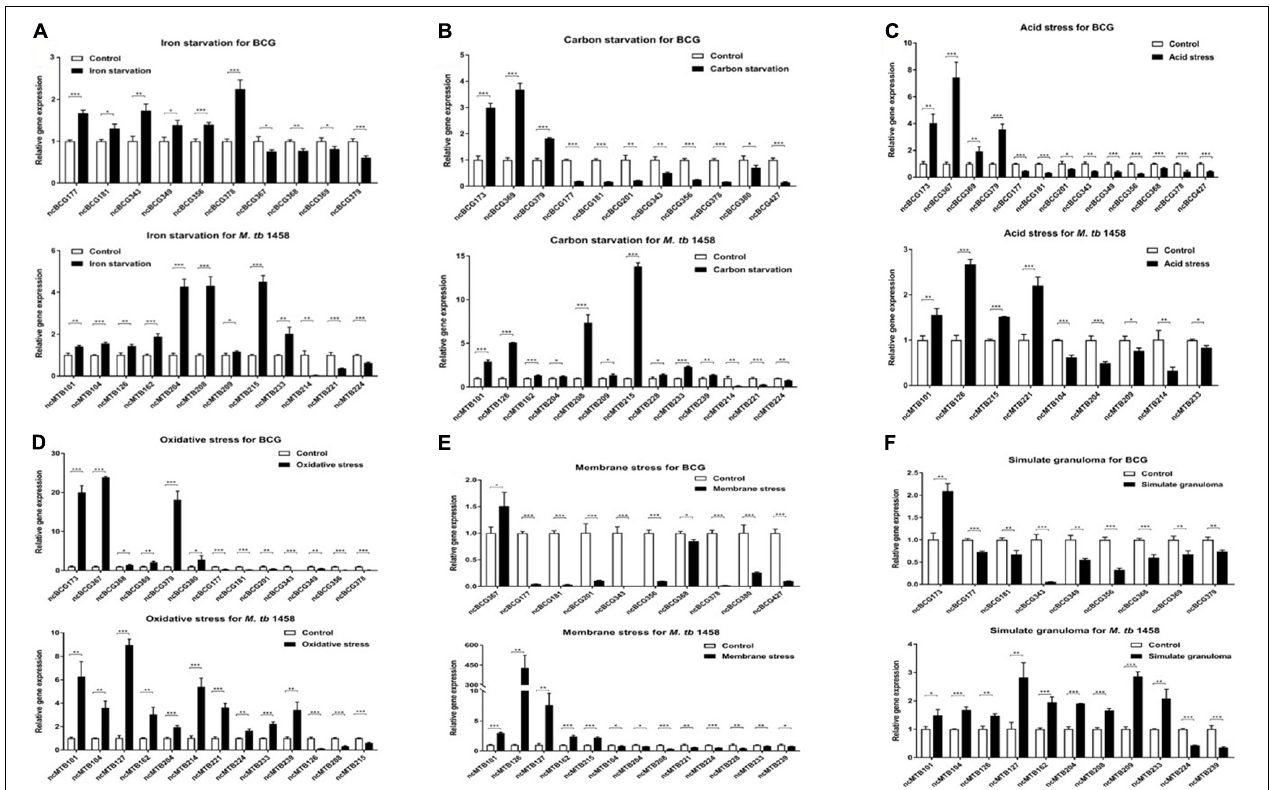
FIGURE 7 | Detection of BCG and M. tb 1458 DEG ncRNAs under different stress culture model. (A) Iron starvation model; (B) carbon starvation model; (C) acid stress model; (D) oxidative stress model; (E) membrane stress model; (F) simulate granuloma stress model. The data used the mean ± SD of three replicate samples, t -test was used for statistical analysis, * p < 0.05, ** p < 0.01, and *** p <